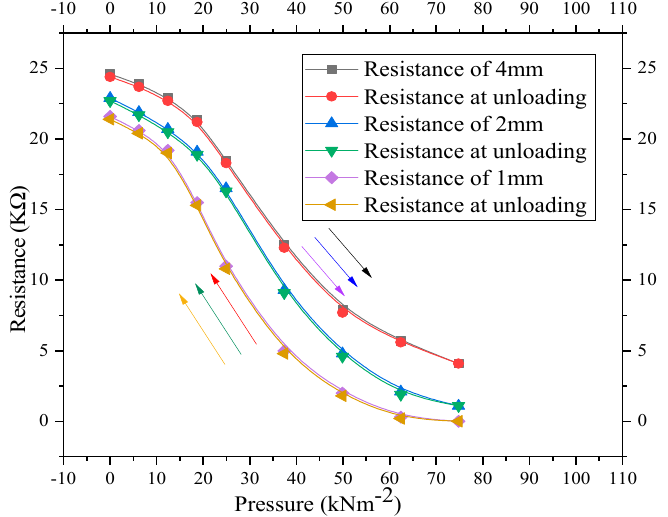
Figure 8. Resistance–pressure characteristics for CNT–graphene composite-based piezoresistive pressure sensors with thicknesses of 1 mm, 2 mm, and 4 mm under cyclic loading.